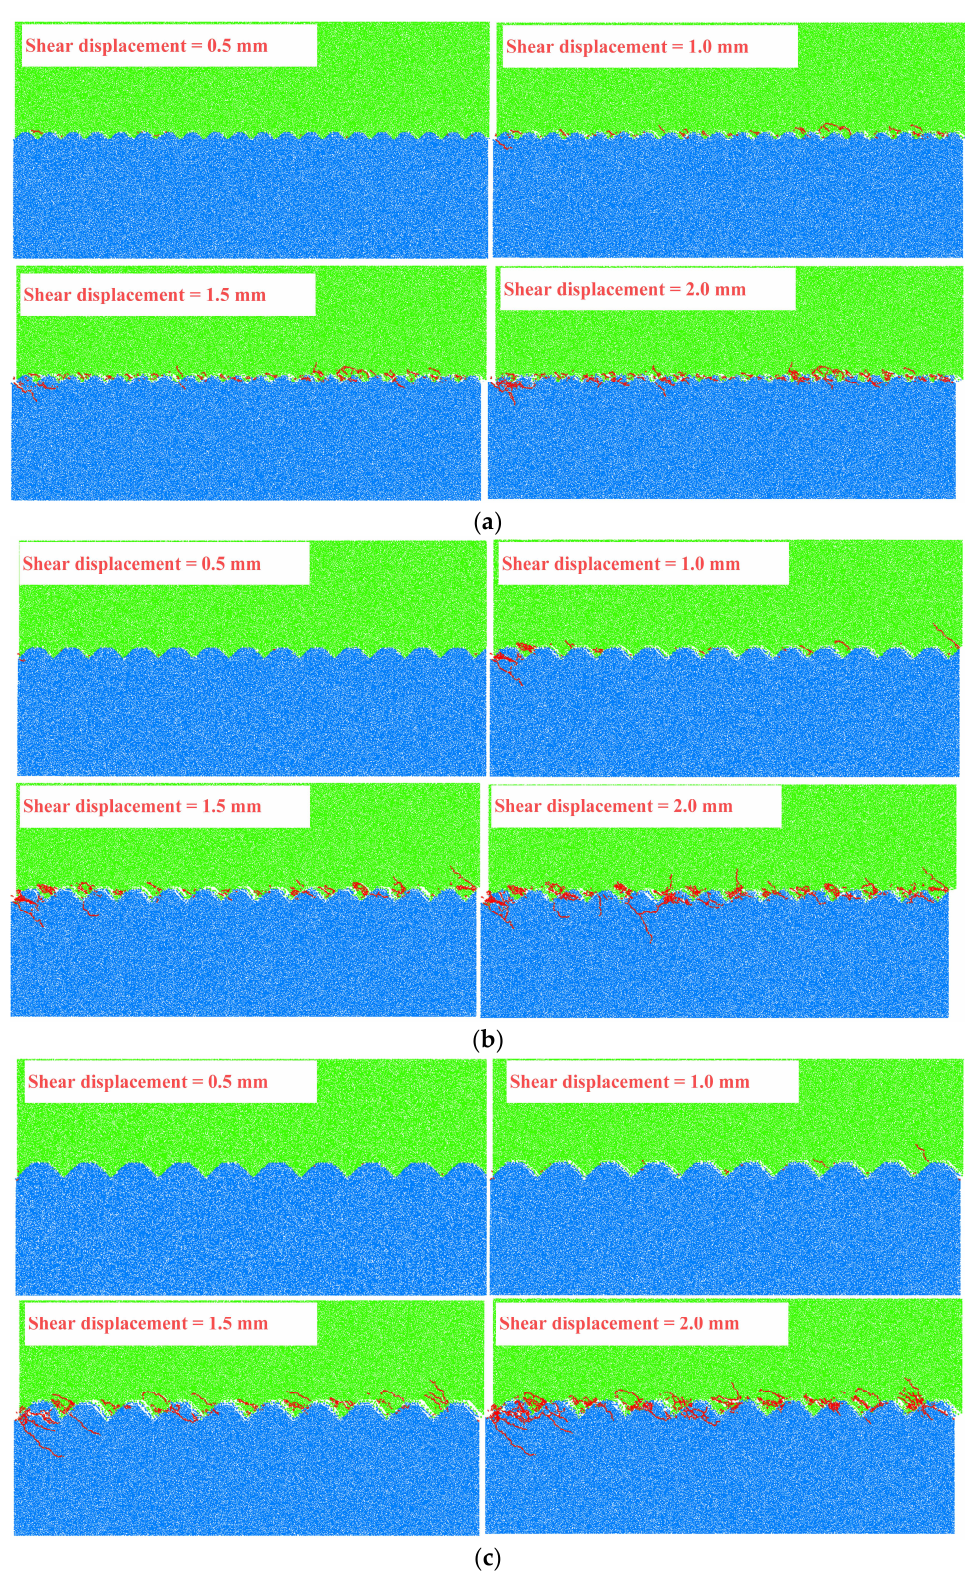
Figure 7. Evolutionary characteristics of shear cracks in dentate joints: ( a ) roughness r = 0.17; ( b ) roughness r = 0.30; ( c ) roughness r = 0.37. The contact force distribution inside the specimen is depicted in Figure 8 (the blue color in the figure indicates contact forces, the darker the color the greater the